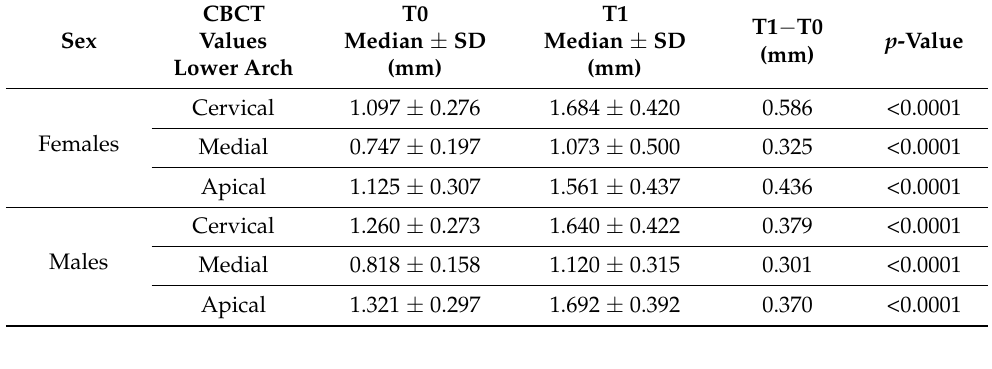
Table 2. Comparison of the level of buccal bone thickness at T0 and T1 in both sexes in the mandibular group.